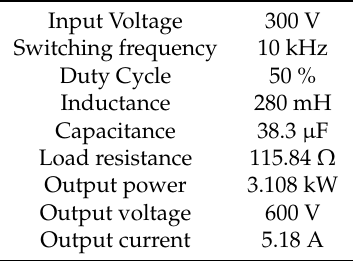
Table 2. High power converter